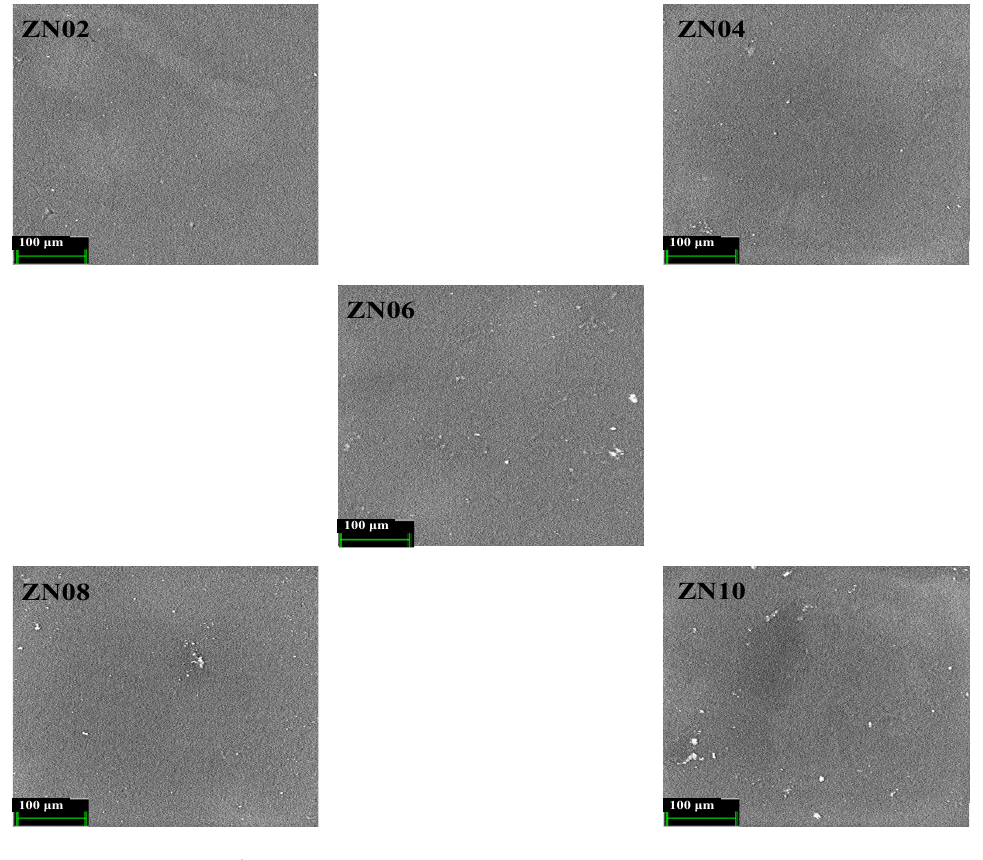
Figure 5. SEM images of